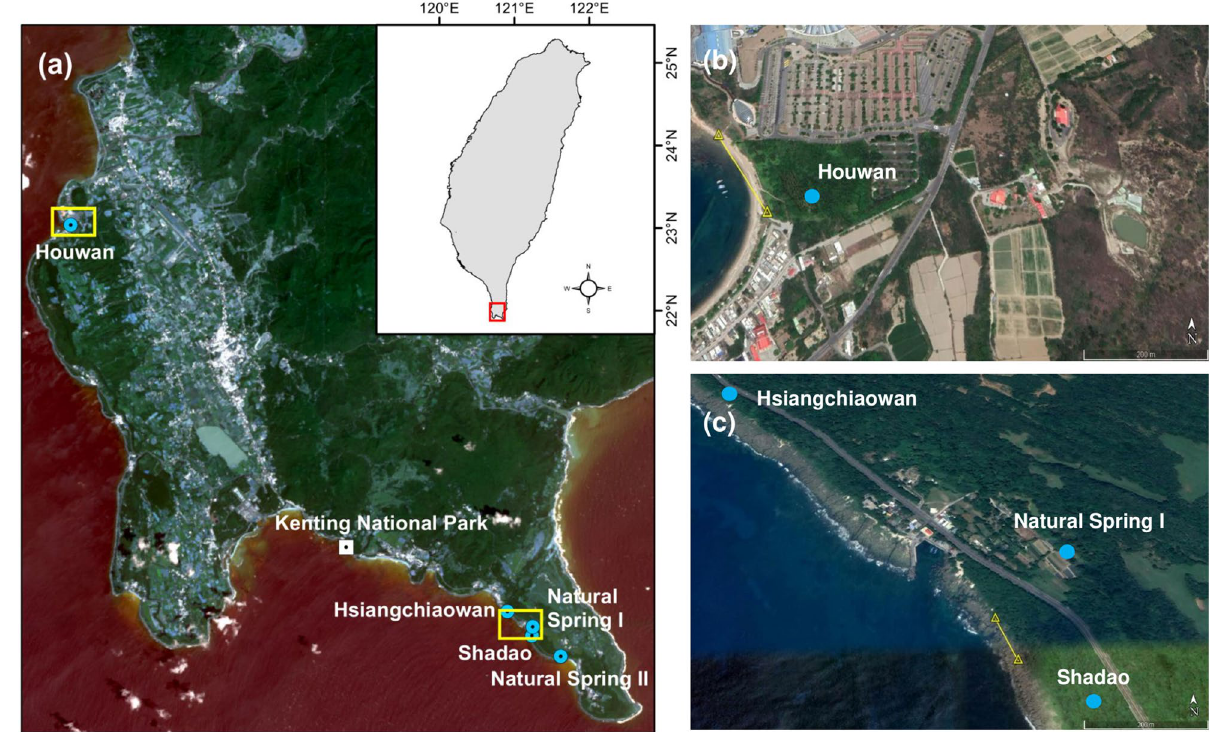
Figure 1. ( a ) Satellite images of Kenting National Park and locations of the study sites indicated as filled blue circles. Monitoring of ovigerous females was carried out near the intertidal zone (marked with yellow line) in ( b ) Houwan and ( c ) the Hsiangchiaowan–Shadao area. For ( a ), map was created using ArcGIS v.10.2, URL: http:// www. esri. com/ softw are/ arcgis/ arcgis- for- deskt op. The background image (13 September, 2015) of panel ( a ) was derived from Landsat 8 Operational Land Imager using GloVis platform (https:// glovis. usgs. gov/).; For ( b ), the satellite imagery is from Google Earth Pro (Map data 2019 Google; https:// www. google. com/ maps/@ 22. 04291 08,120. 70334 4,847m/ data= !3m1!1e3); For ( c ), the satellite imagery is from Google Earth Pro (Map data 2019 Google; https:// www. google. com/ maps/@ 21. 92513 93,120. 83720 65,1213m/ data=